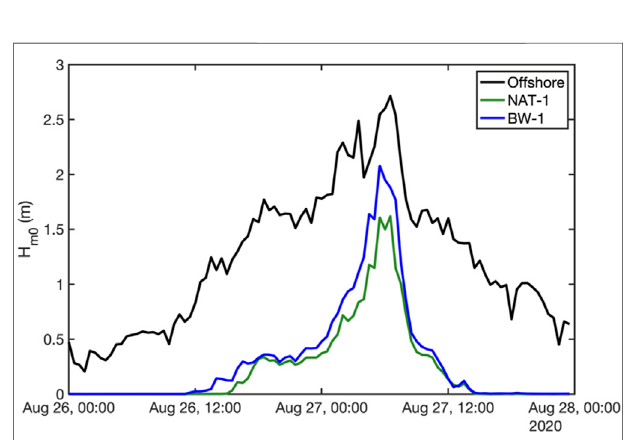
FIGURE 6 | Comparisons of zero-moment wave heights at the offshore wave gauge, NAT-1 and BW-1.